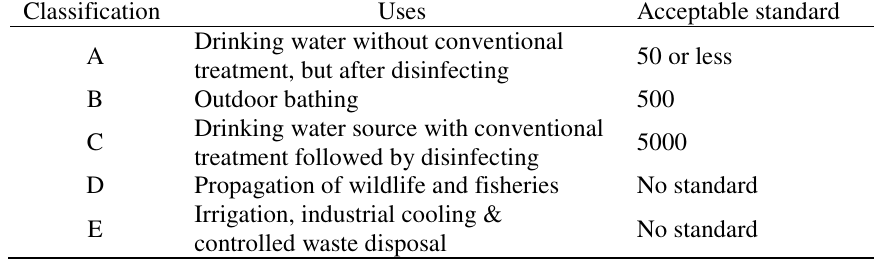
Figure 5. Alkalinity upstream and downstream samples. Table 6. Standards of acceptable total coliform in inland surface water, according to Indian Standards 2296 10 . (Indian standards of drinking water-specification BIS 10500: 1991) .